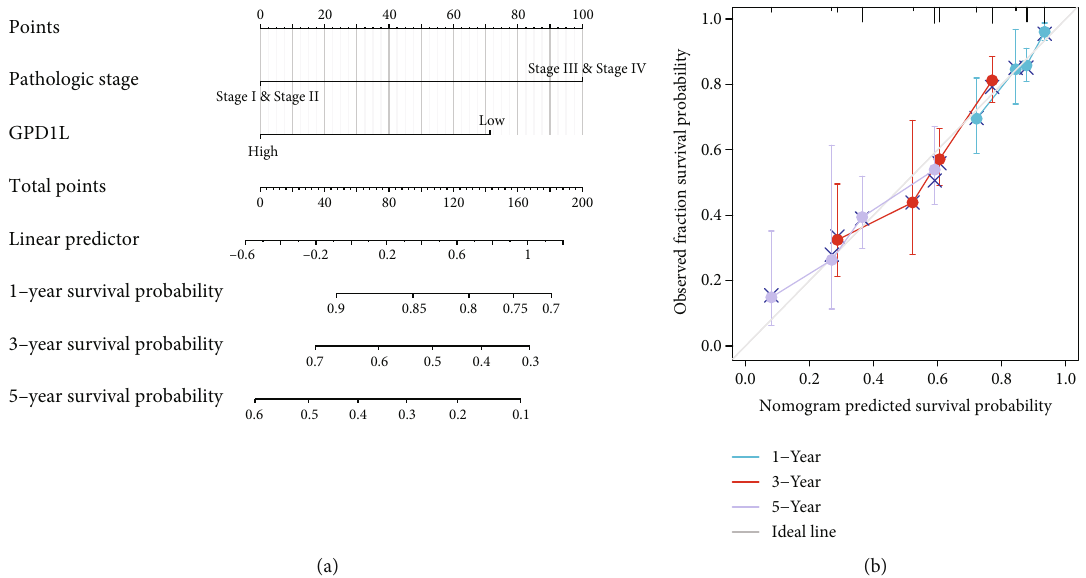
Figure 5: A quantitative method to predict the chance of 1-, 3-, and 5-year overall survival for patients diagnosed with LUAD. (a) A nomogram that estimates the likelihood of 1-, 3-, and 5-year overall survival for patients diagnosed with LUAD. (b) Calibration plots of the nomogram used to assess the overall likelihood of survival at 1, 3, and 5